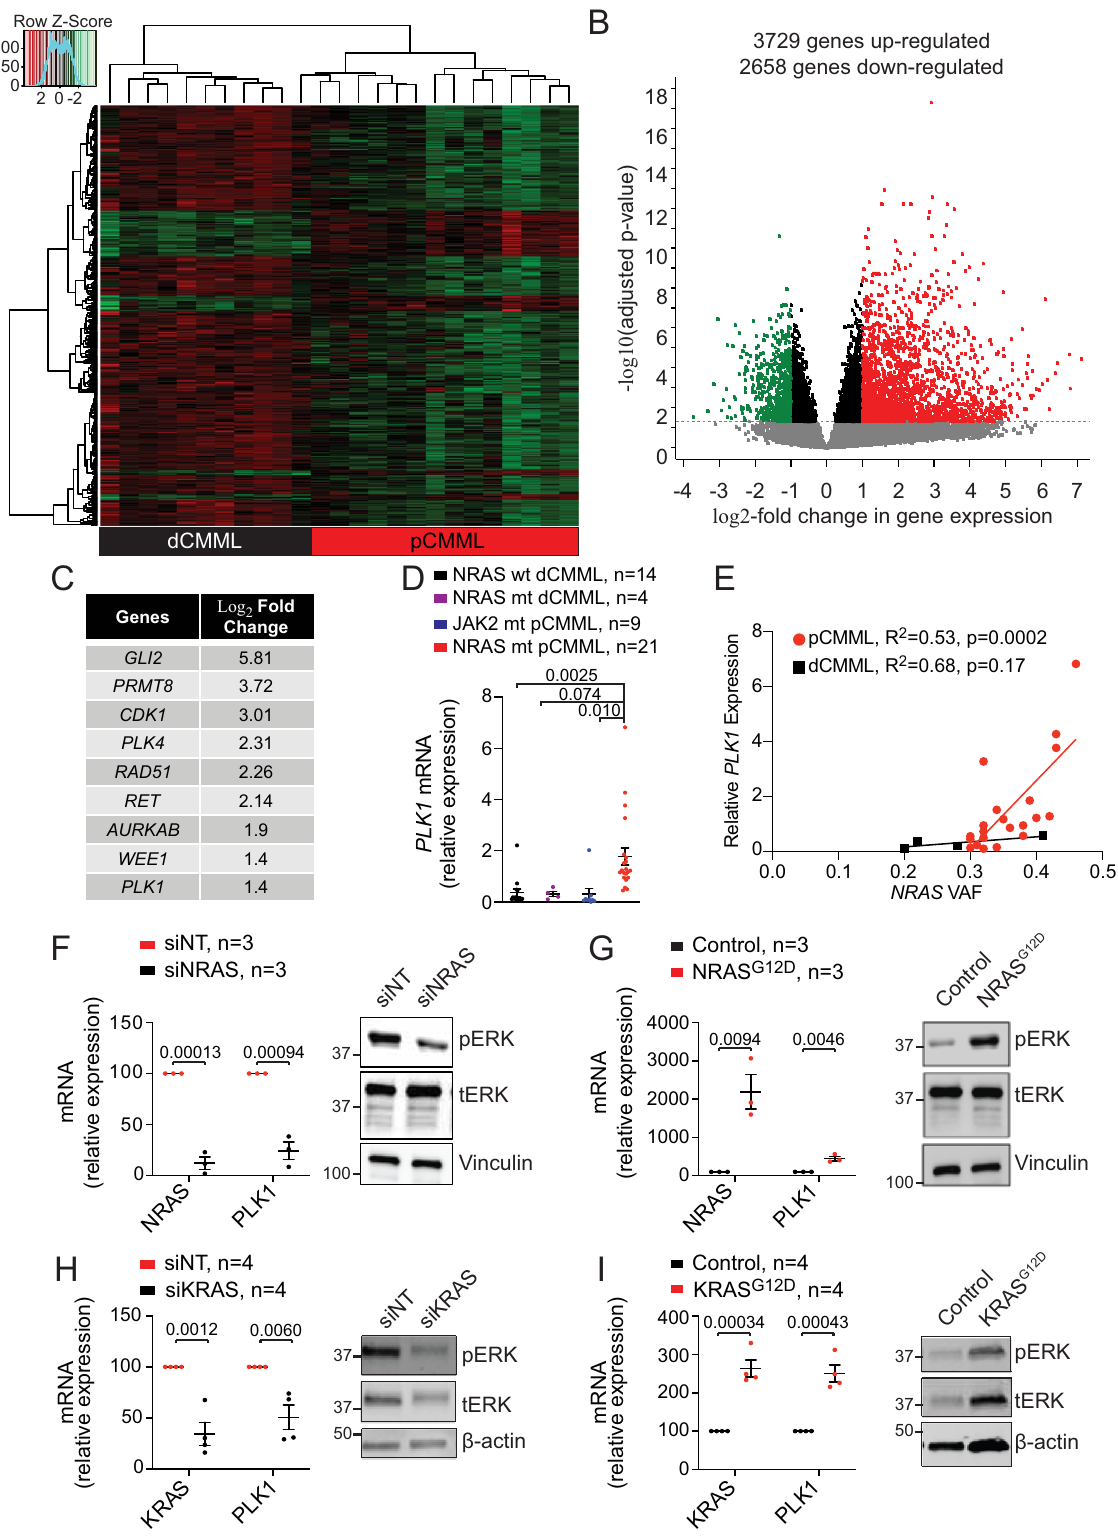
RNA-seq analysis detected overexpression of KMT2A ( MLL1 ) and its coactivator MEN1 in RAS mutant pCMML samples versus controls (Fig. 6A), with no statistical difference between RAS mutant pCMML and RAS wild-type dCMML. Unlike in AML, where KMT2A fusions and partial tandem duplications (PTD) are frequent, FISH ( fl uorescence in situ hybridization) and